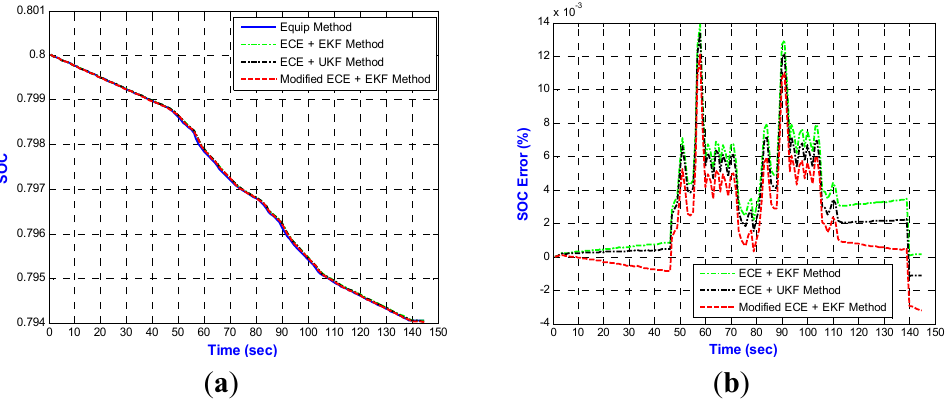
Figure 22. SOC estimation results in the humanoid robot test (a) SOC profile; (b) SOC error